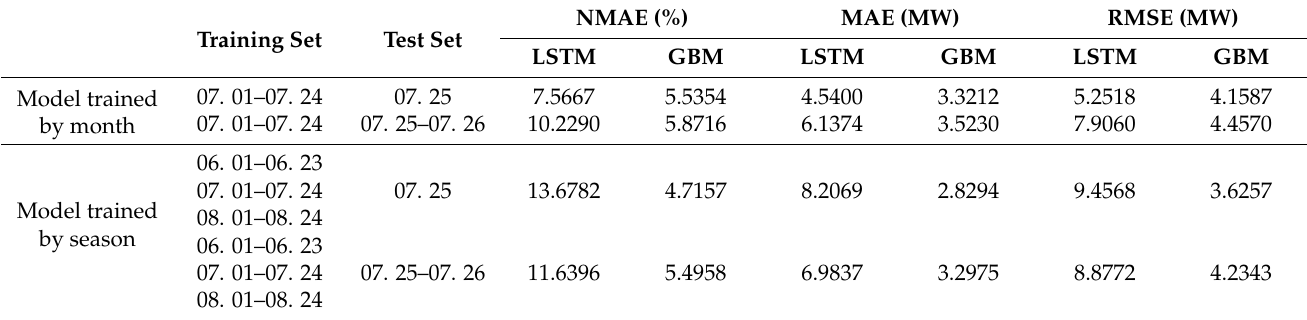
Table 7. Comparison of the GBM model with the LSTM model.